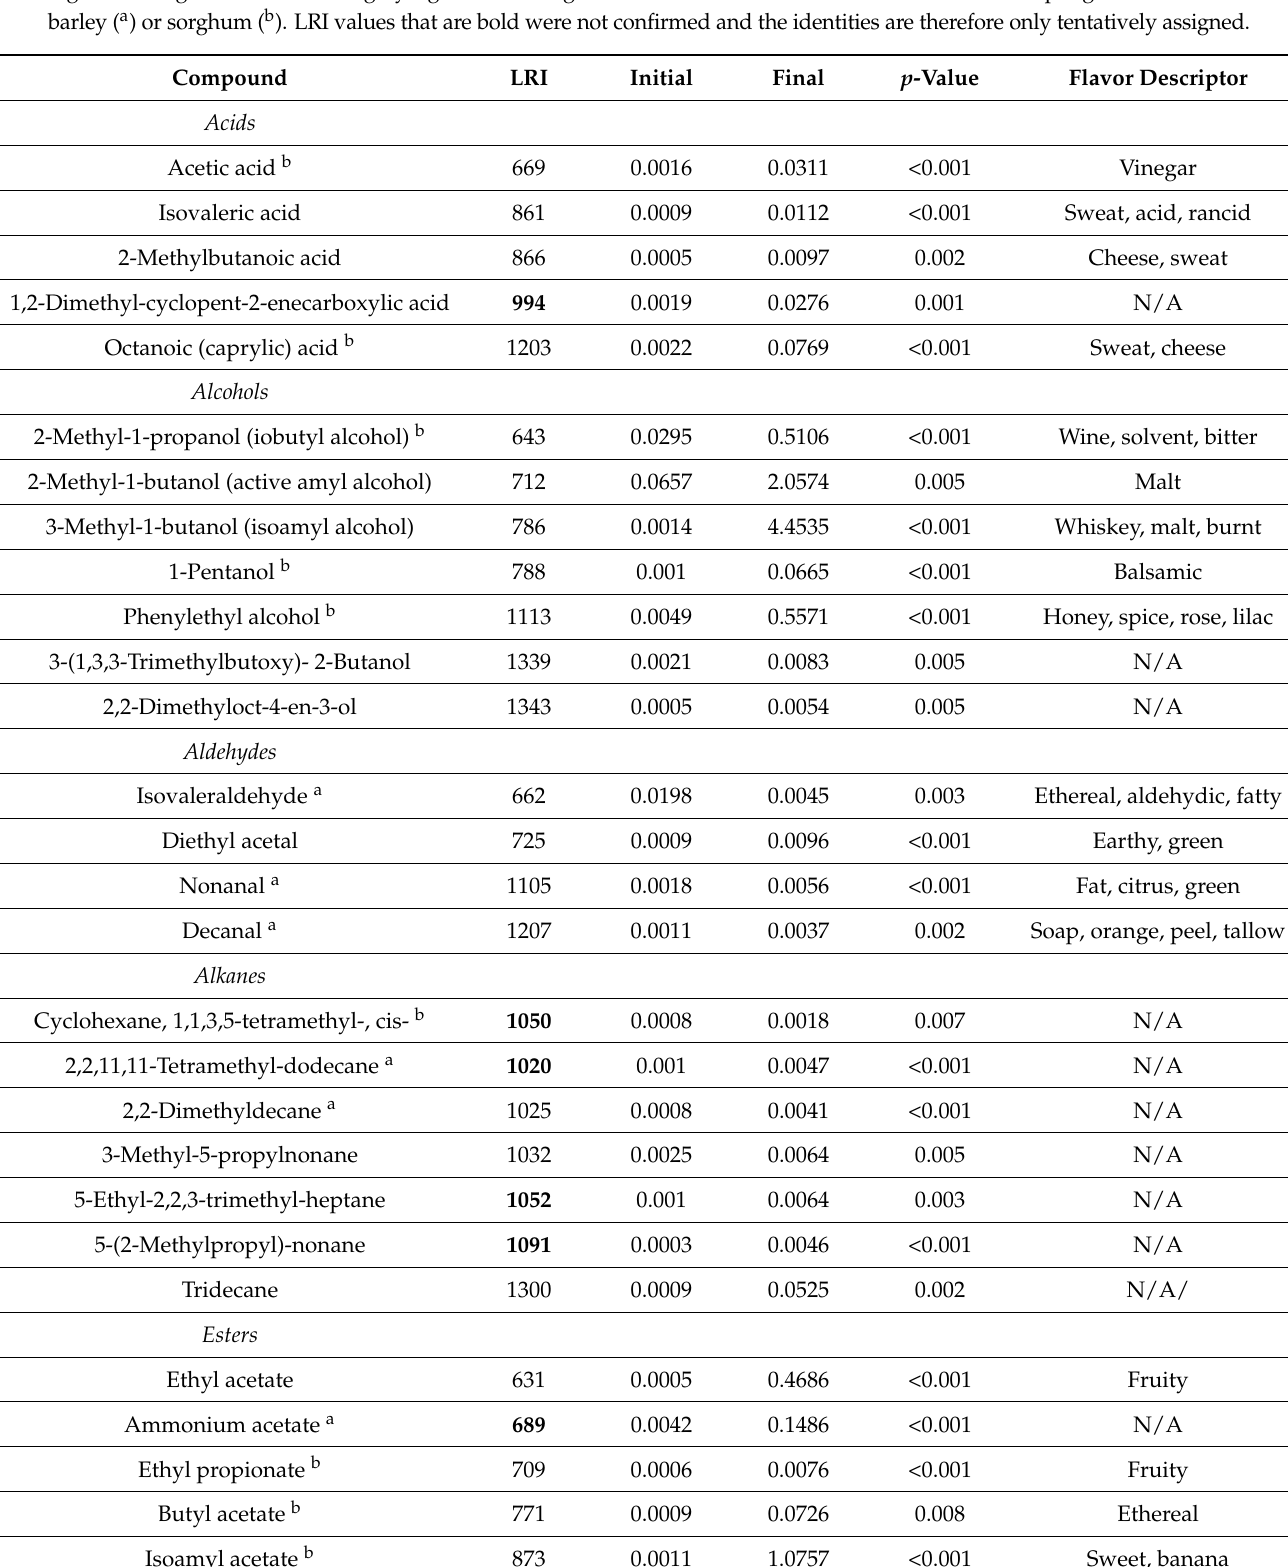
Table 1. Semi-volatile compounds showed a highly significant change in median amount relative to the internal standard regardless of grain material. A highly significant change in median amount relative to internal standard per grain material for barley ( a ) or sorghum ( b ). LRI values that are bold were not confirmed and the identities are therefore only tentatively